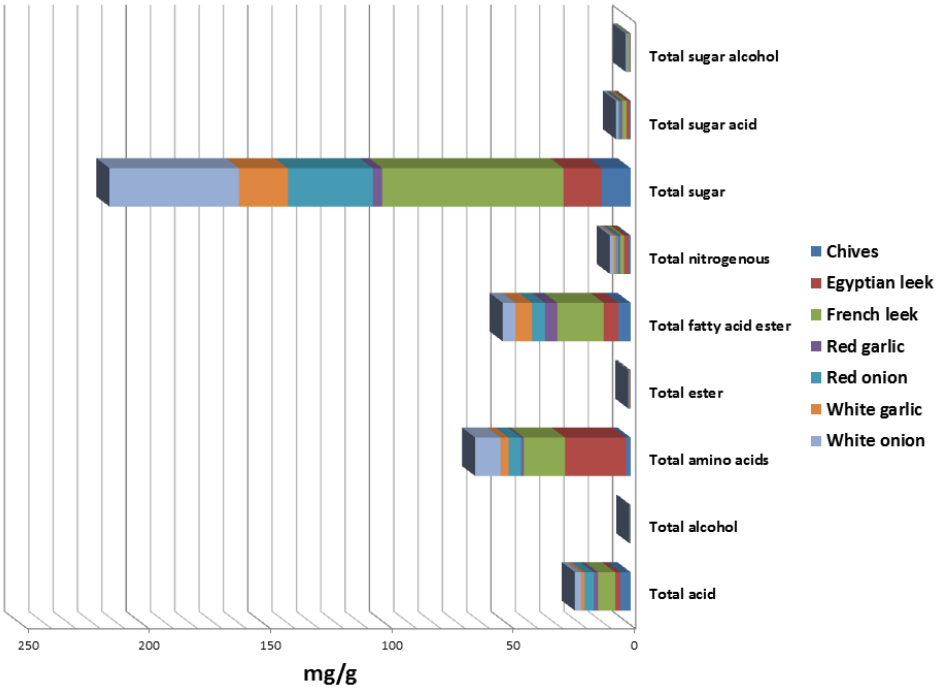
Figure 2. Different classes of identified primary metabolites quantified as mg/g in seven Allium species.